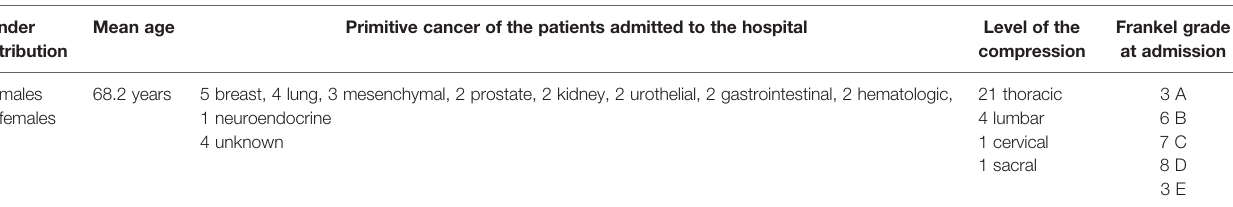
TABLE 4 | Characteristics of the patients with spine metastasis and neurological compression admitted (n = 27) to the Spine and Spinal Cord Surgery department in the year 2021. Gender distribution